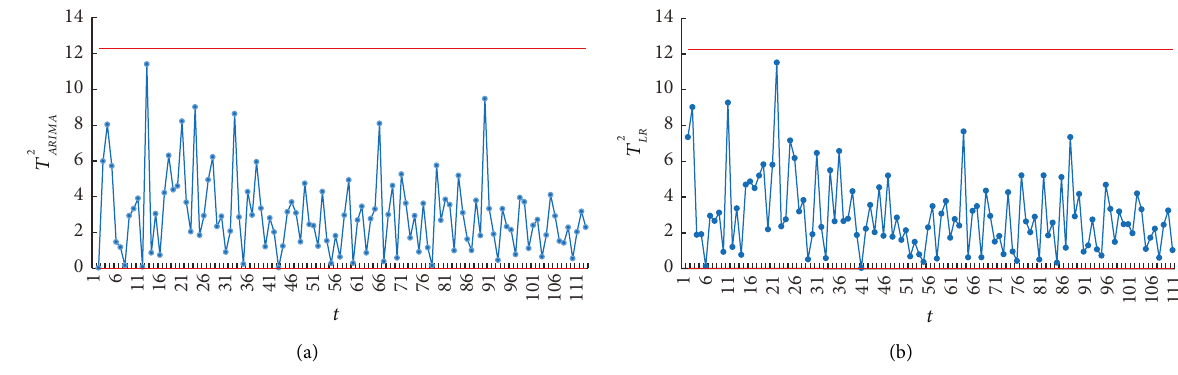
Figure 6: T 2 control chart based on residuals issued from (a) ARIMA and (b) LR